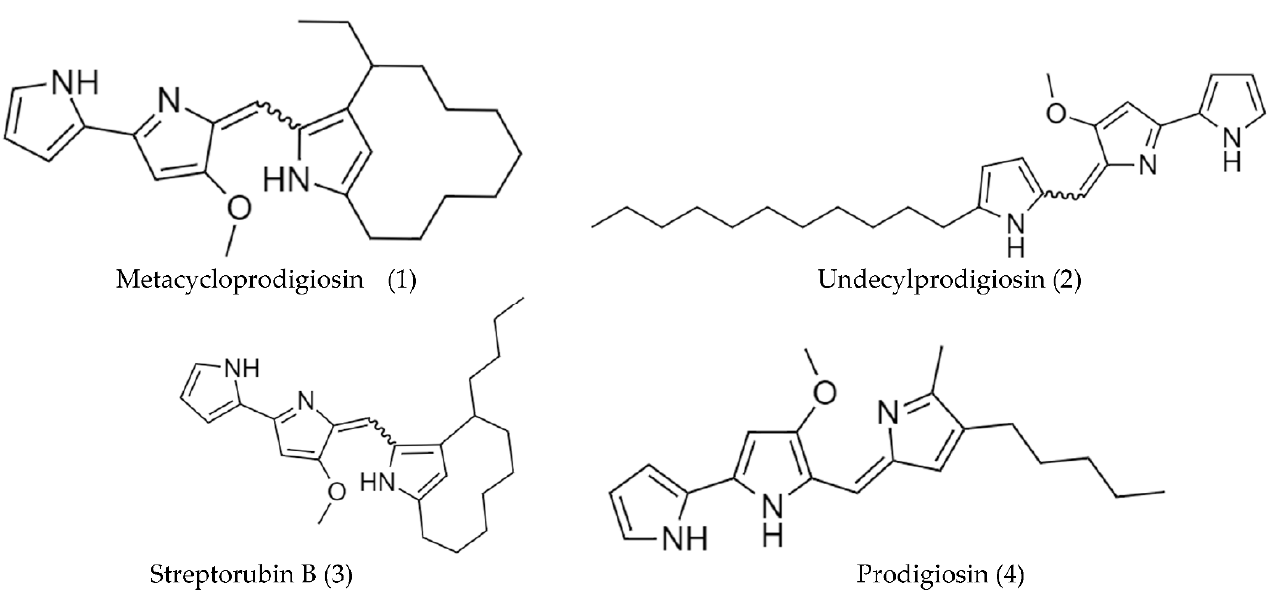
Figure 6. Chemical structures of prodiginins.